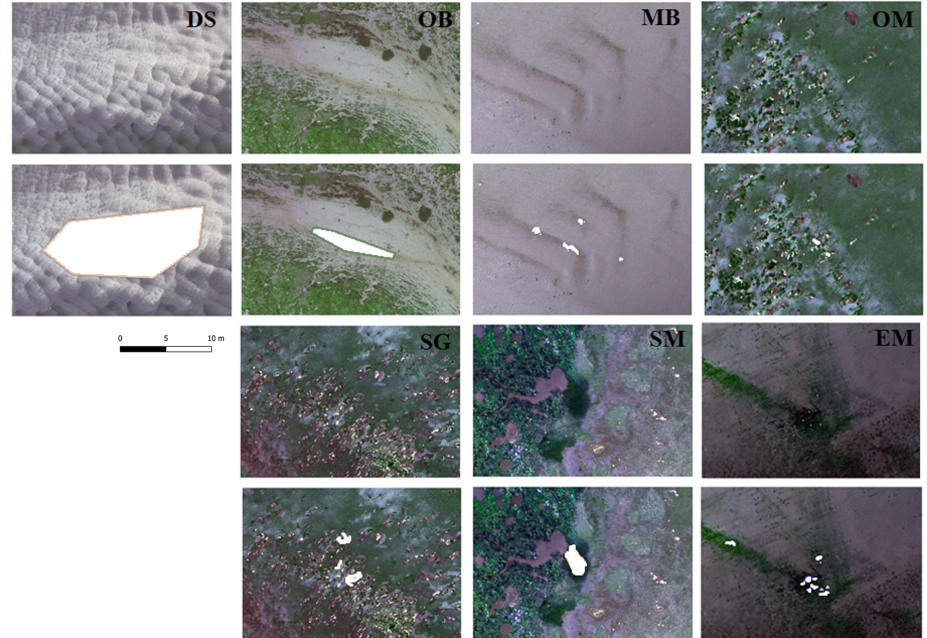
Figure 3. Gallery of images and polygons. OM—Other Macroalgae inc. Fucus ; MB— Microphytobentos ; EM— Enteromorpha ; SM—Saltmarsh; SG—Seagrass; DS—Dry Sand; OB—Other Bareground. Images with white polygons are examples of polygons used for